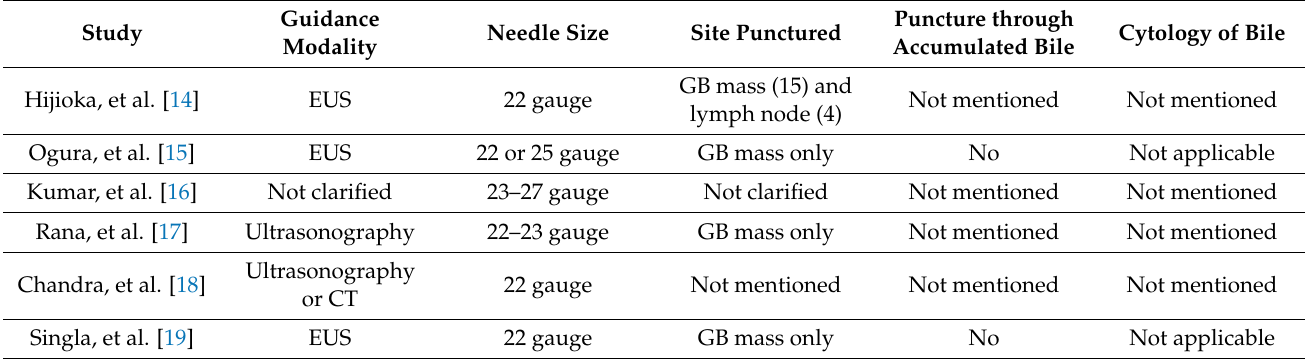
Table 2. Technical characteristics of the procedure in each